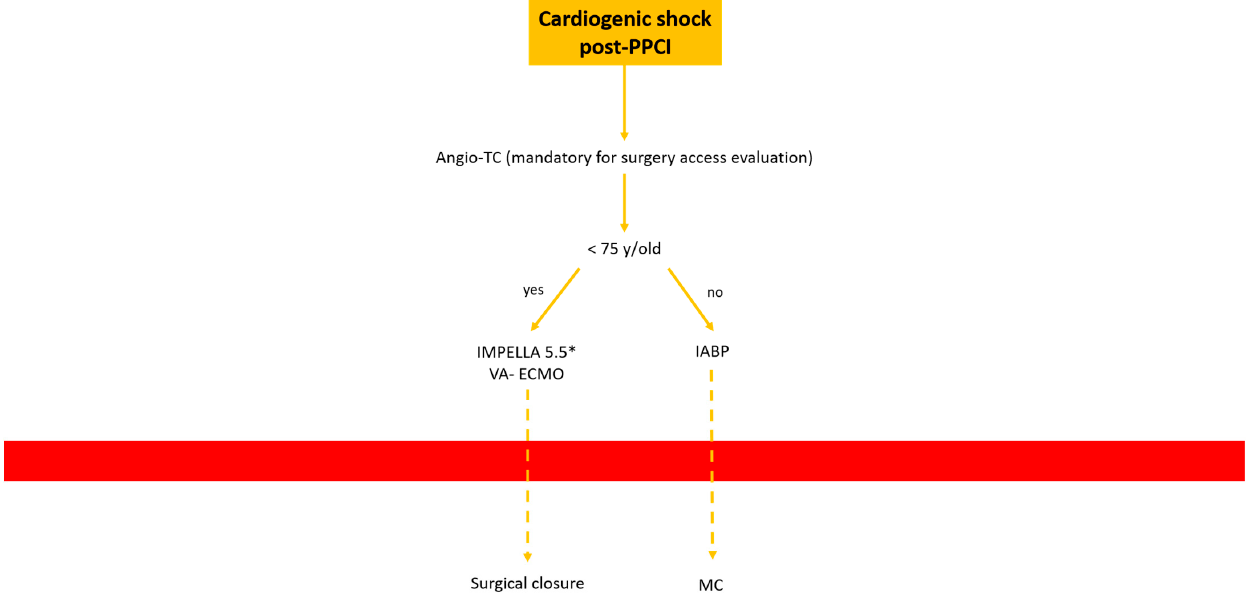
Figure 9. Decisional algorithm in setting of cardiogenic shock (CS) post-PPCI. * Surgical cutdown.